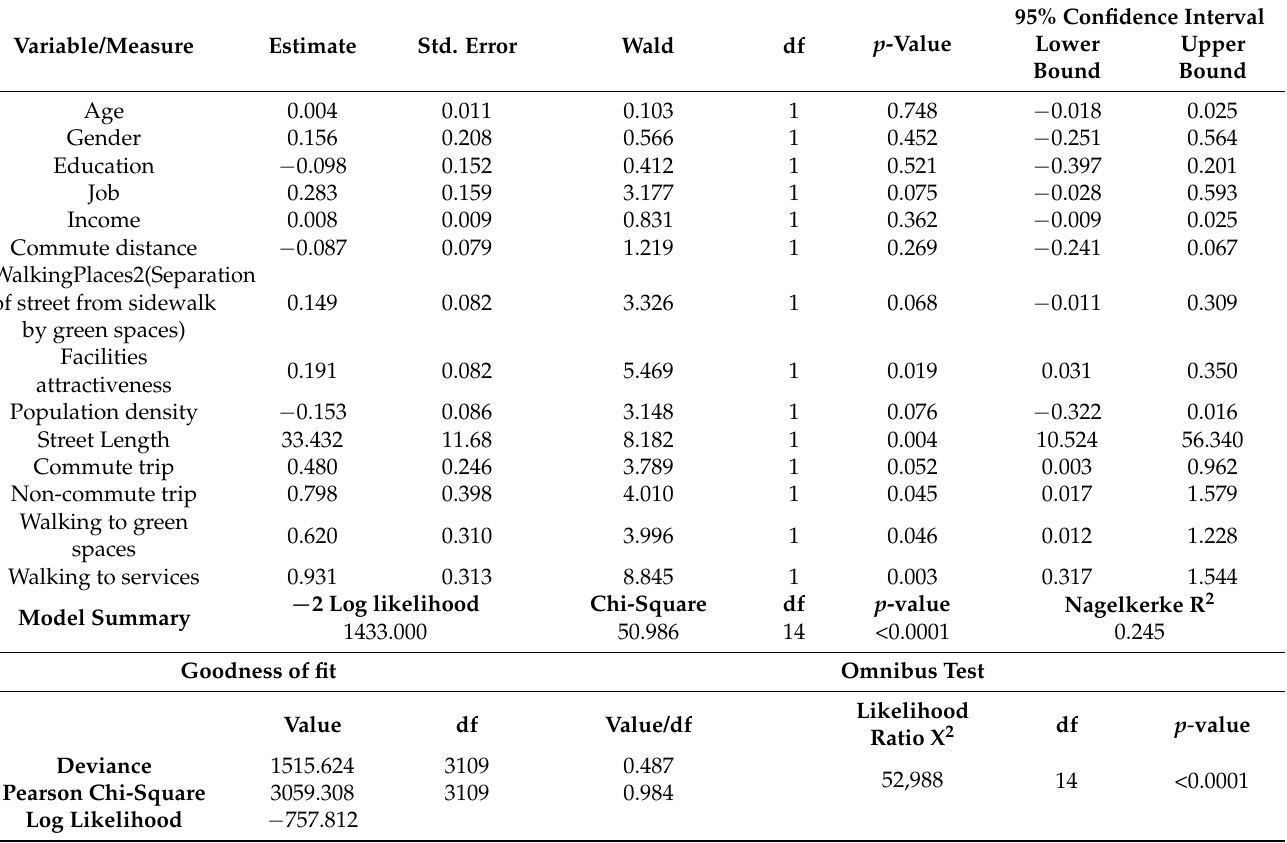
Table 3. Model for the association between active lifestyle and life